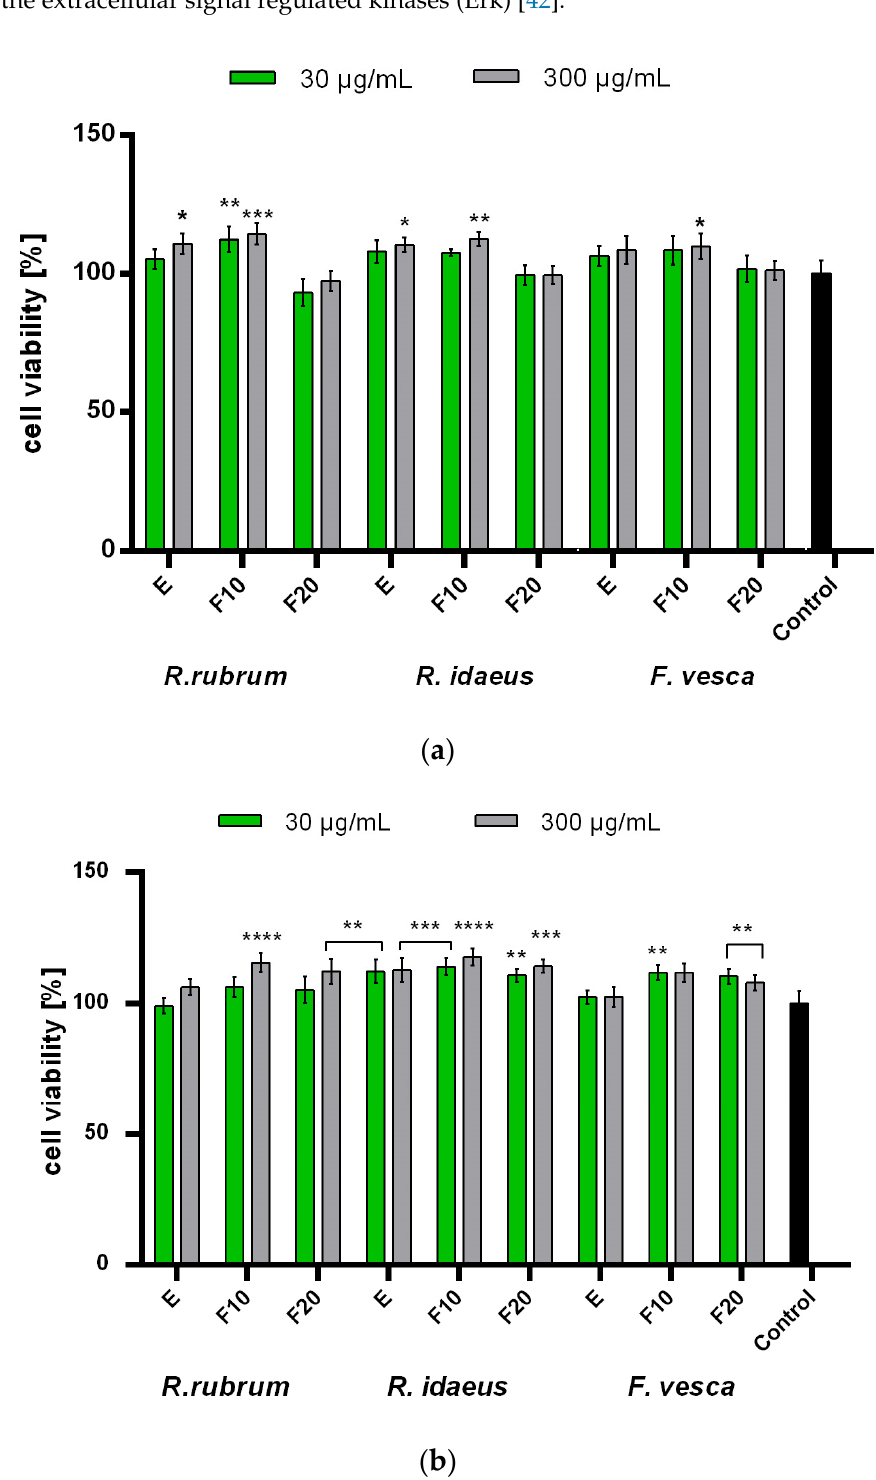
activating the focal-adhesion kinases (FAK) and c-Jun N-terminal kinases (JNK), as well as the extracellular signal regulated kinases (Erk) [42].